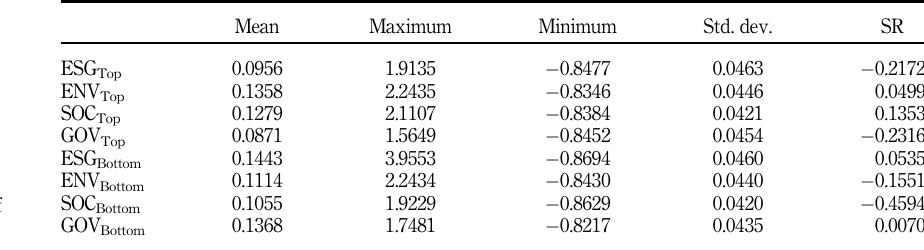
Table 3. Characteristics of